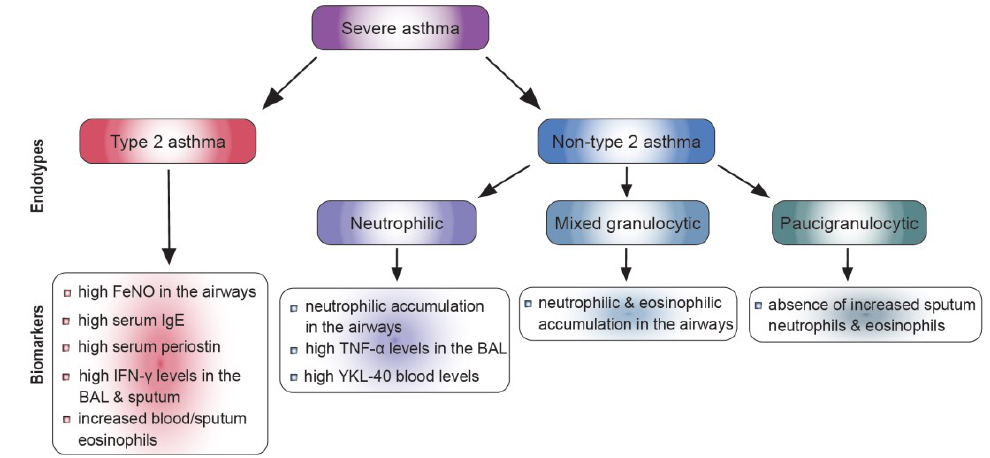
Figure 1. SA endotypes and